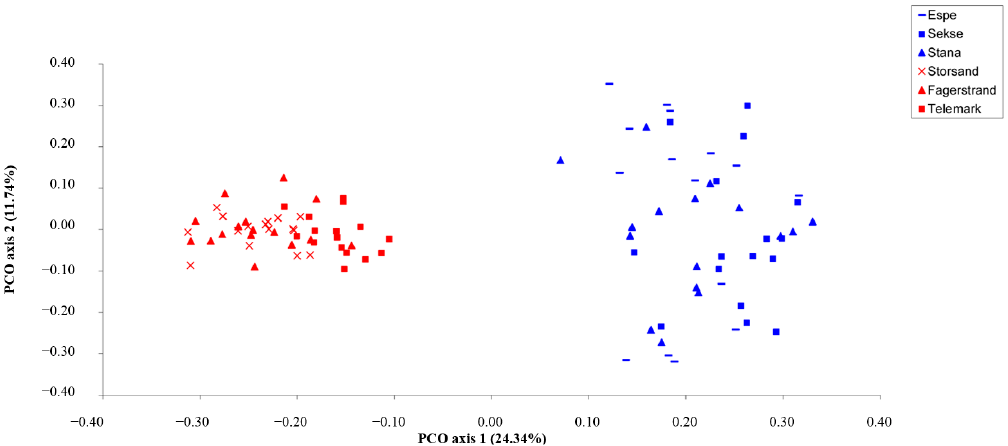
Figure 2. PCO score plot of 95 A. conjugella individuals using 410 polymorphic AFLP bands. The geographical origin of each A. conjugella individual is indicated by the symbols listed at the right; red: Eastern region and blue: Western region (Eigenvalue for each axis is given in brackets).